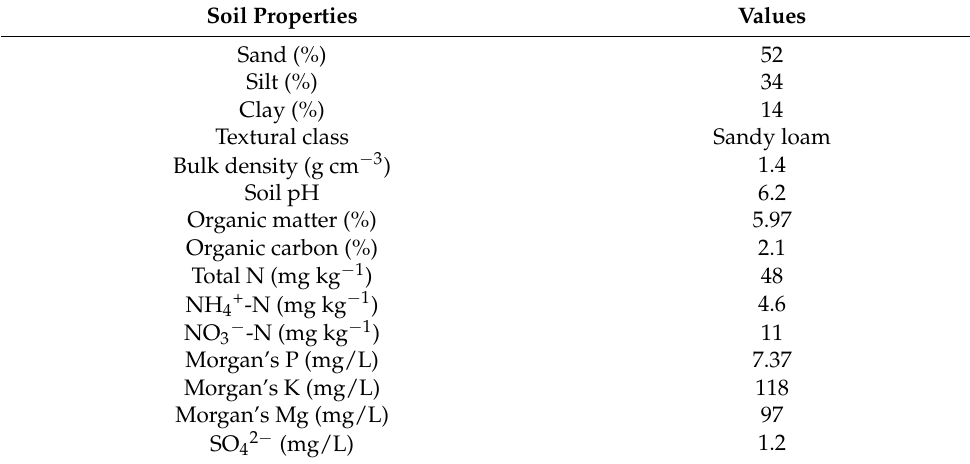
Table 1. The initial physical and chemical characteristics of the study site. Soil